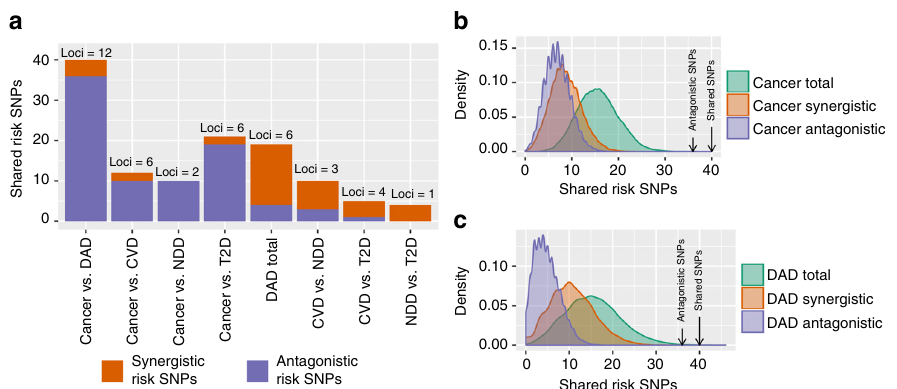
Fig. 5 Antagonism between cancer and degenerative ageing diseases on the genetic level. a Shared synergistic and antagonistic risk SNPs between cancer and degenerative ageing diseases (DAD). “ DAD total ” indicates the total number of synergistic and antagonistic risk SNPs in the pairwise comparison between all three categories of degenerative ageing diseases. The total number of independent genomic loci in which the shared SNPs are contained is displayed on top of the bars. CVD cardiovascular diseases, NDD neurodegenerative diseases, T2D type 2 diabetes. b Randomization tests. Distributions depict the frequency at which the corresponding number of synergistic, antagonistic and total number of shared risk SNPs were encountered between cancer risk SNPs and randomly drawn risk SNPs from non-ageing-associated traits in 10,000 repetitions. Arrows indicate the actual observed number of antagonistic and total shared risk SNPs between cancer and degenerative ageing diseases. c Same as in b for degenerative ageing diseases instead of